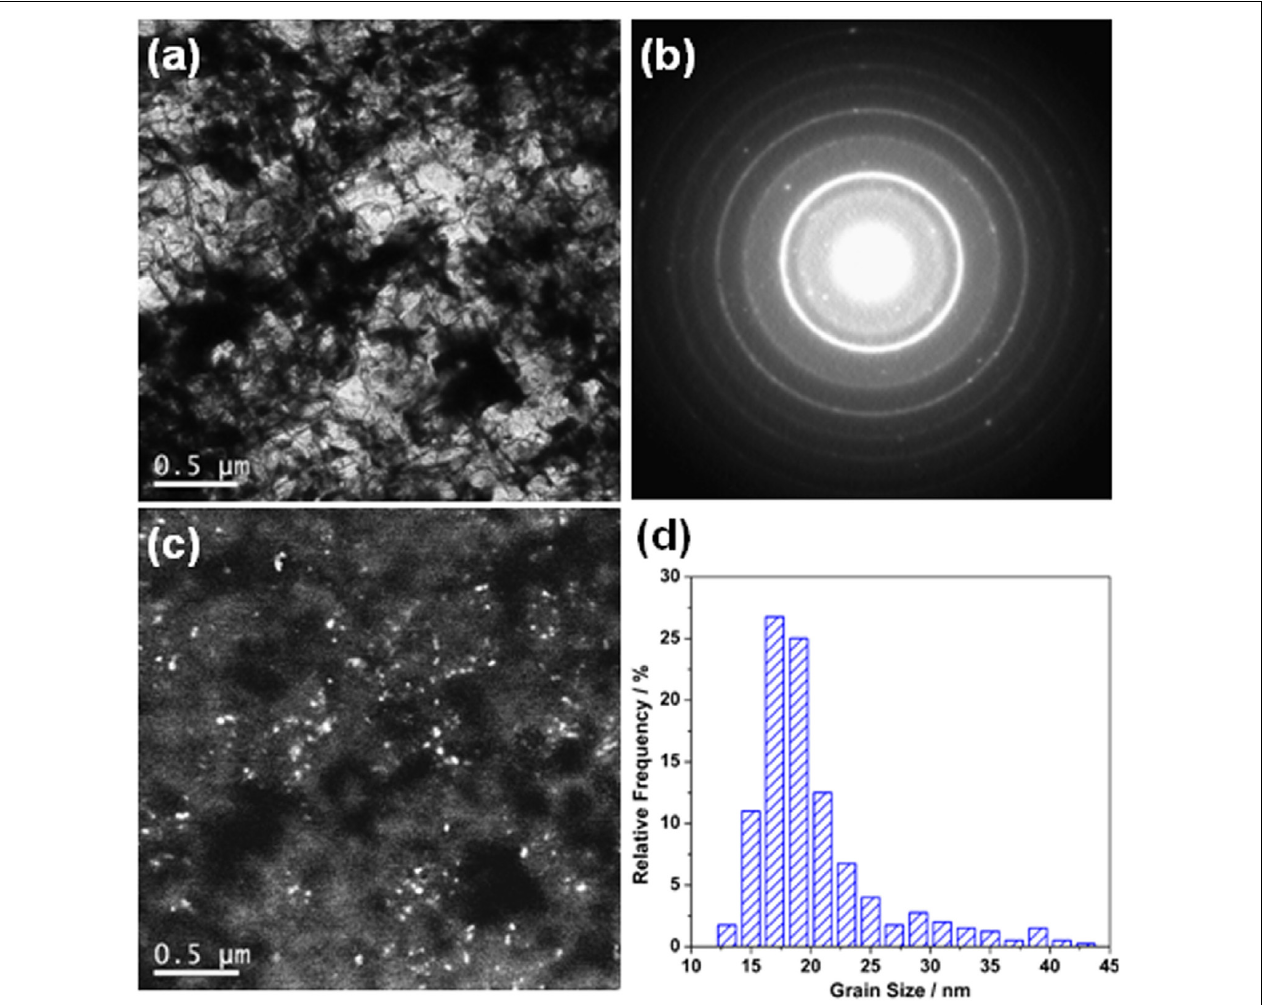
FIGURE 7 | Transmission electron microscope results of the 2205 DSS prepared with the excessive Fe 2 O 3 of 0%: (a) bright-field image, (b) selected area electron diffraction, (c) dark-field image, and (d) size distribution of the crystal